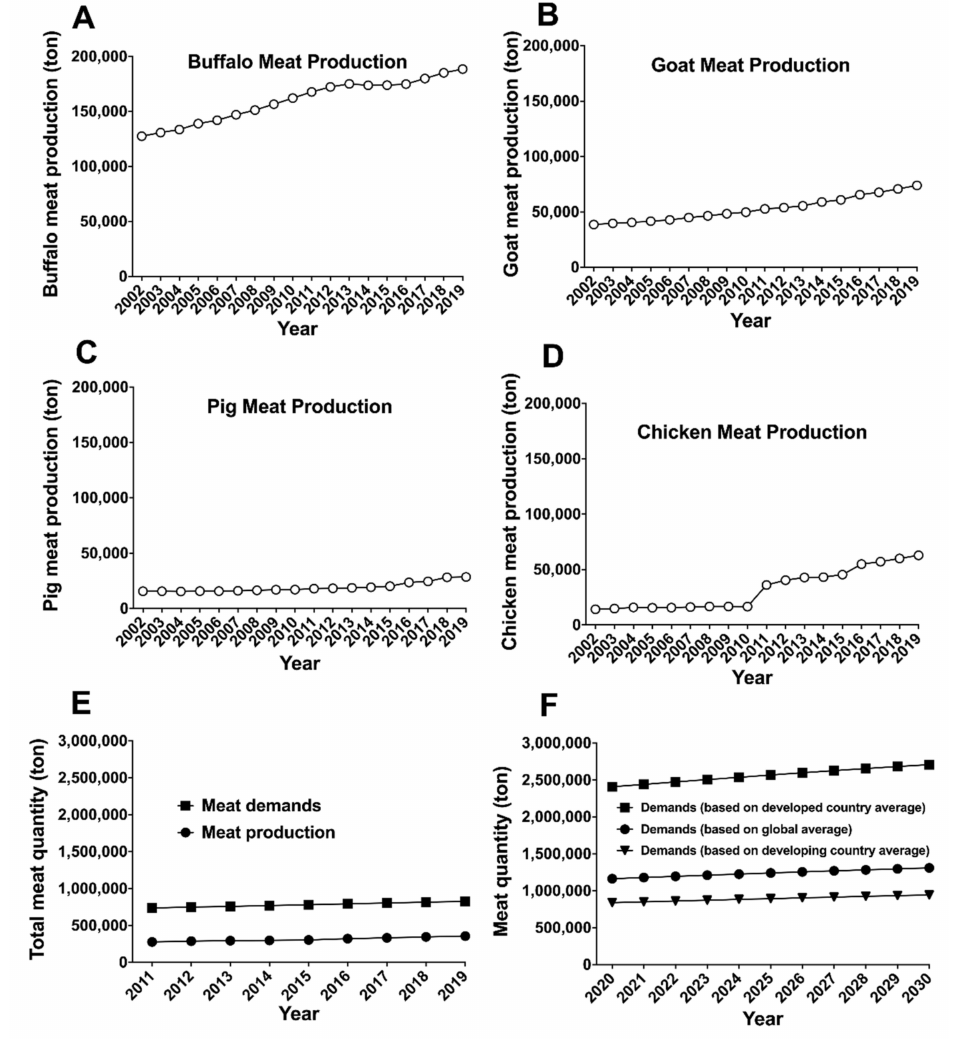
Figure 3. Status of meat production in Nepal (MOALD, 2017; MOALD, 2019) [15,16]. ( A ): The trend of total annual buffalo meat production (in ton) during the period 2002–2016, ( B ): The trend of yearly total goat meat production (in ton) for the period 2002–2016, ( C ): The trend of total annual pig meat production (in ton) during the period 2002–2016, ( D ): The trend of yearly total chicken meat production (in ton) during the period 2002–2016. ( E ): The trend of total annual meat production compared to demands